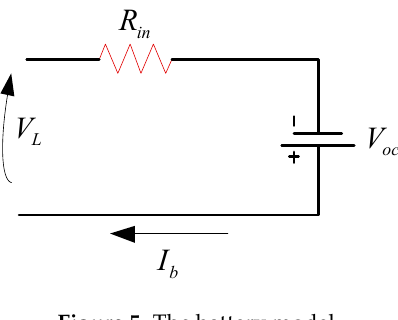
Figure 5. The battery model.